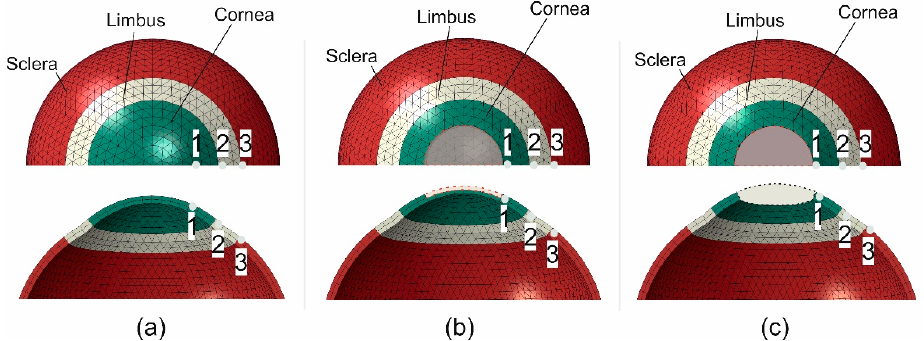
Figure 5. Three full eye models corresponding to ( a ) a healthy physiological state, ( b ) a simplified refractive surgery model, and ( c ) a simplified penetrating keratoplasty model. Images show front views (top) and cross-sectional views (bottom). The regions within red dash lines represent the removed